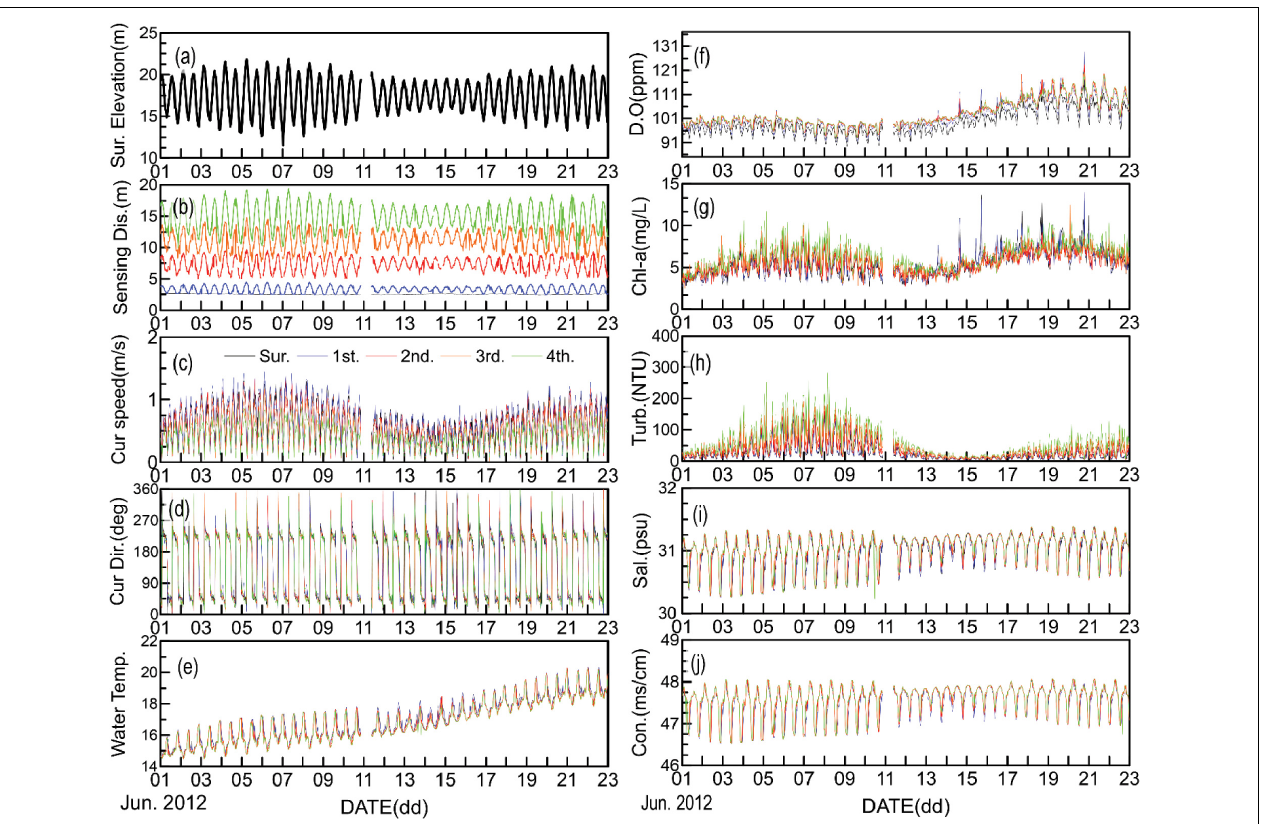
FIGURE 11 | Time variation of water properties measured by INBUS-2 at location P1 from June 1 to 23, 2012: (a) surface elevation, (b) distances from the four internal layers to the seabed, (c) current speed, (d) current direction, (e) water temperature, (f) dissolved oxygen (DO), (g) chlorophyll (Chl), (h) turbidity, (i) salinity, (j) conductivity. Black solid lines, measured at the water surface; blue lines, measured in the first internal layer; red lines, measured in the second internal layer; orange lines, measured in the third internal layer; green lines, measured in the fourth internal